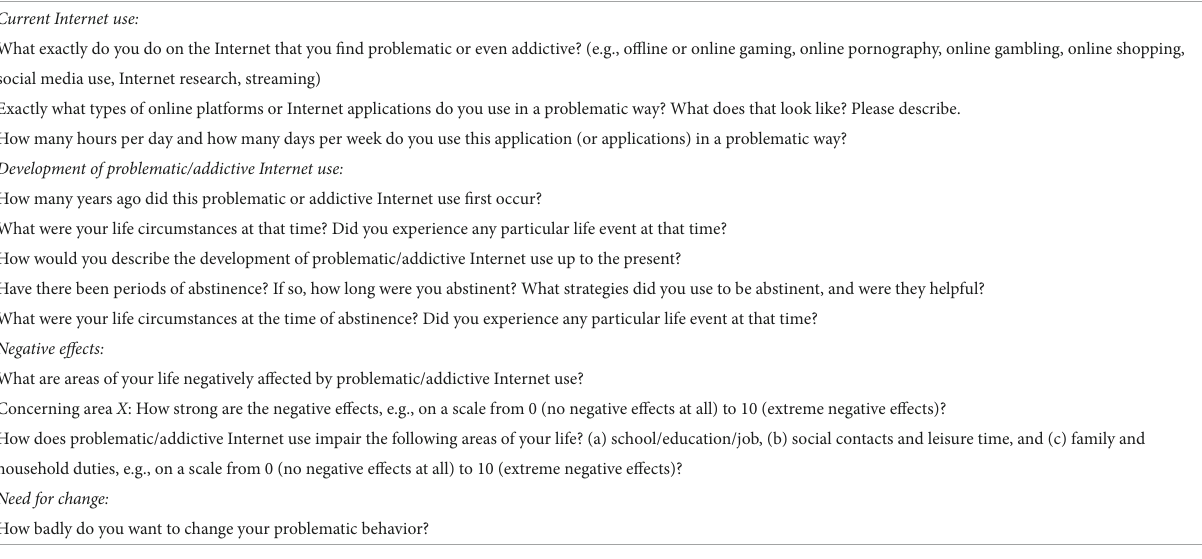
TABLE 2 Possible questions for anamnesis of Internet use [inspired by